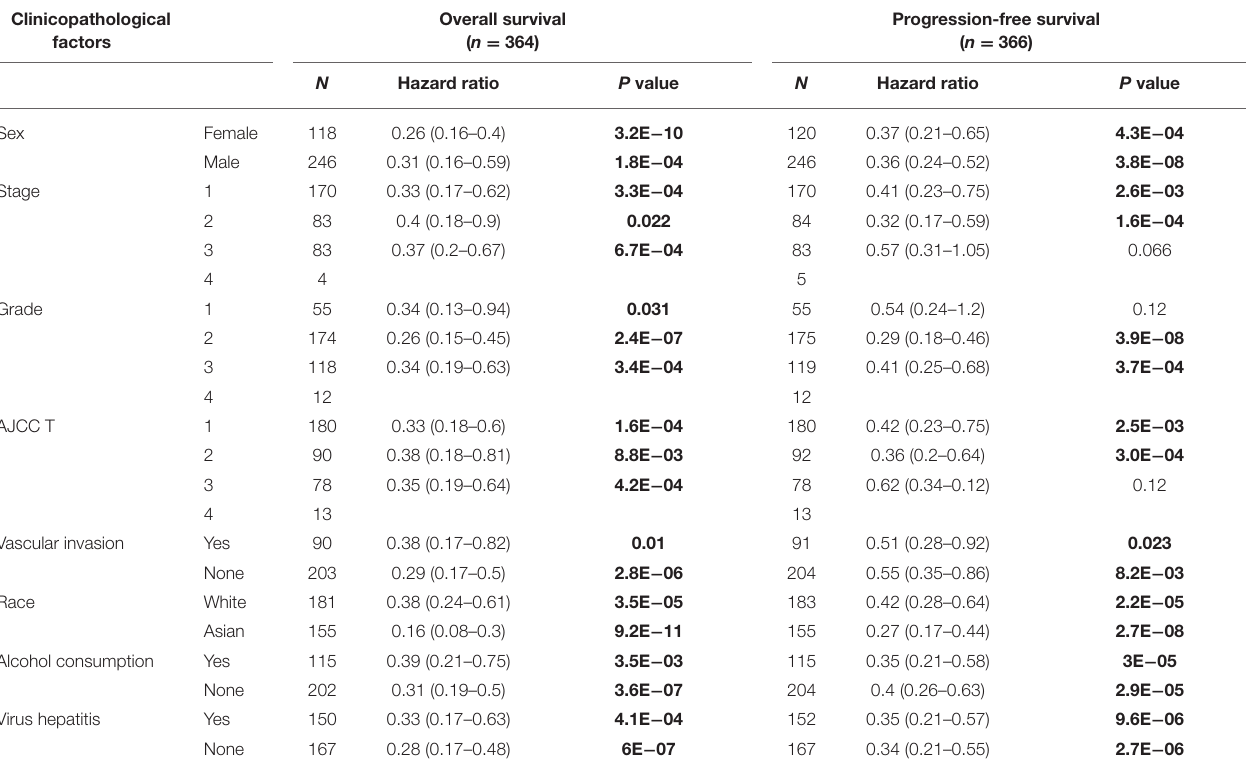
TABLE 1 | Correlation of CLEC3B expression and prognosis in hepatocellular carcinoma patients with different clinicopathological factors via Kaplan–Meier plotter.